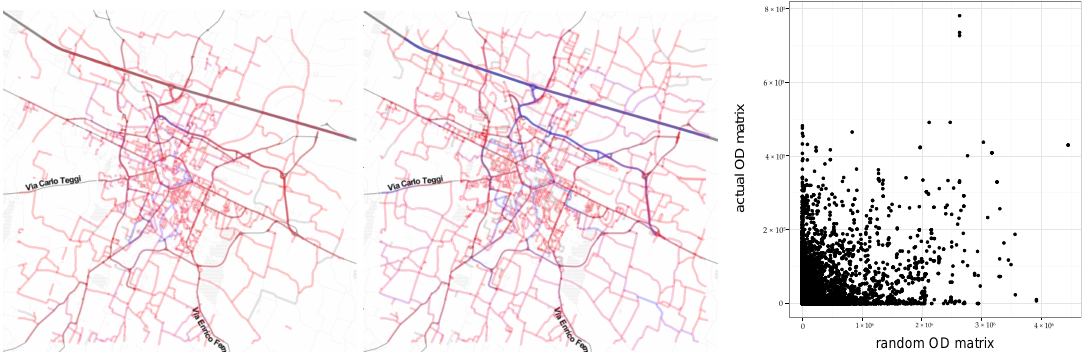
Figure 13. ( left ) Exemplary traffic result from original OD matrix. ( center ) Same traffic from random OD matrix. ( right ) Scatter of the road-level traffic counts resulting from the two OD